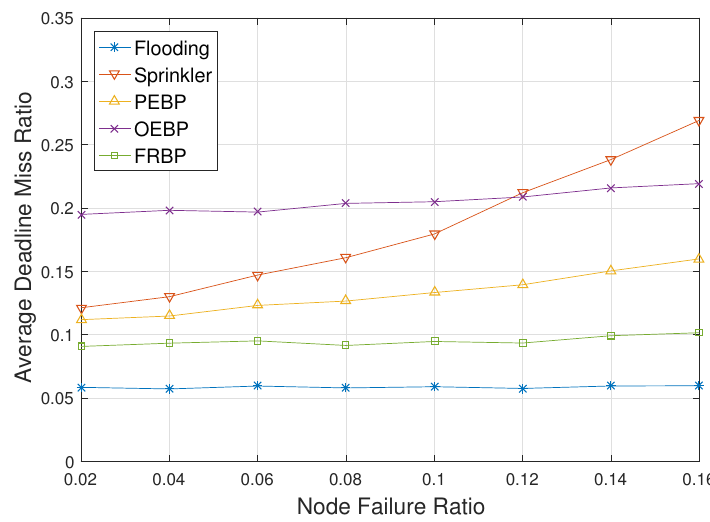
Figure 8. Deadline missed ratio impacted by the node failure ratio.